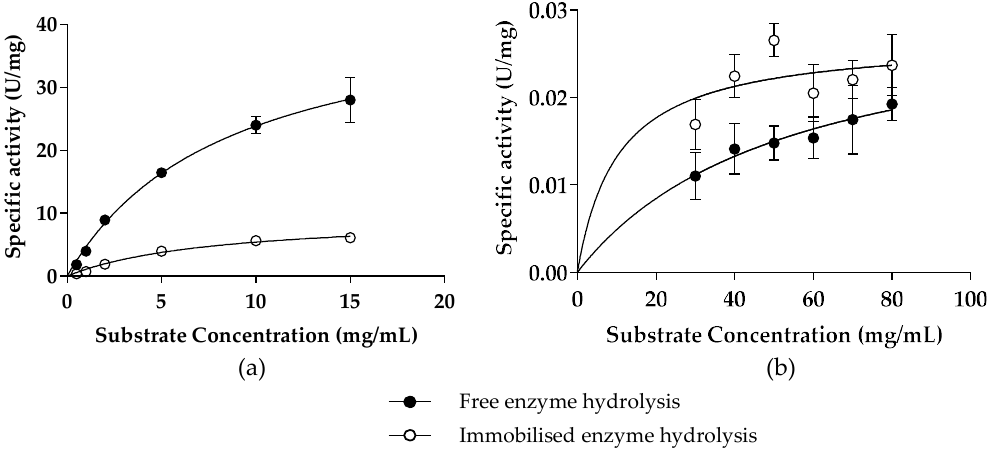
Figure 4. Michaelis–Menten kinetics of free and immobilised endo-1,4-β-mannanase hydrolysing ( a ) LBG (0.5–15mg/mL) (30-min, 55 °C) and ( b ) SBM (30–80 mg/mL) (48 h, 55 °C). The kinetic parameters were determined at the optimal pH and temperature for both enzymes. The values were presented as mean ± SD (n = 3).